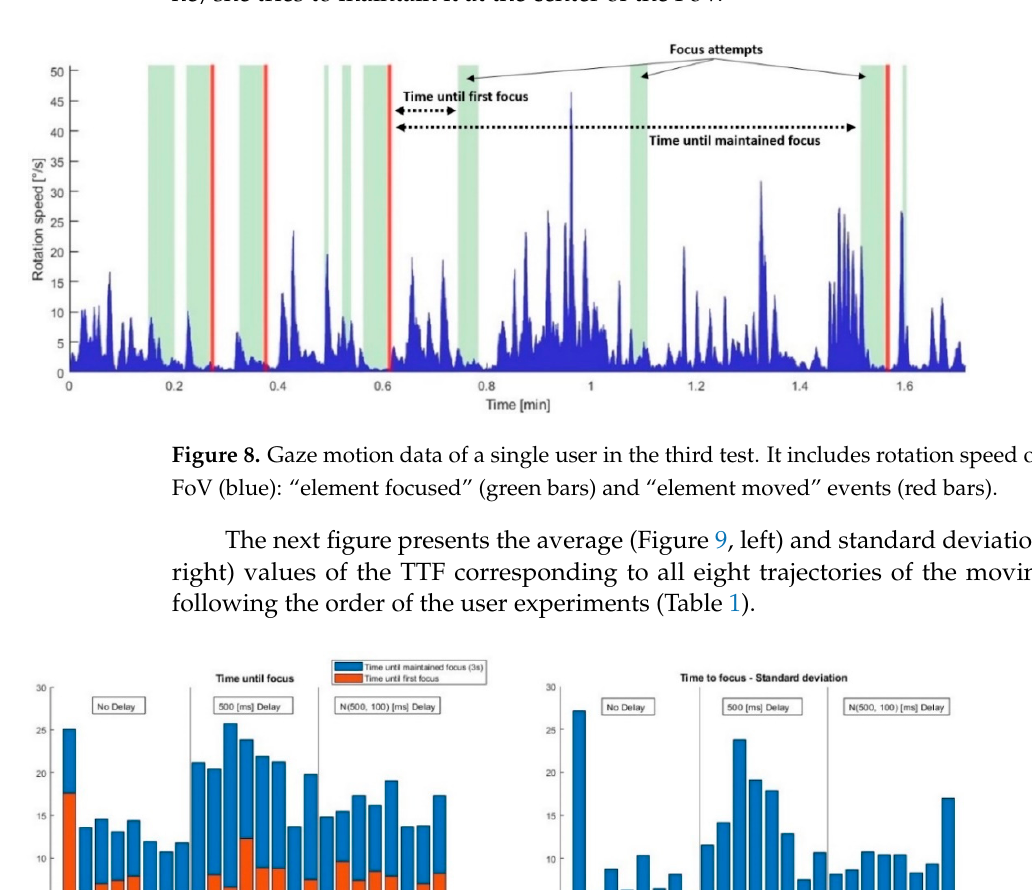
Figure 9. Time inverted until the element was steadily focused (3 s) per trajectory: average ( left ) and standard deviation ( right )